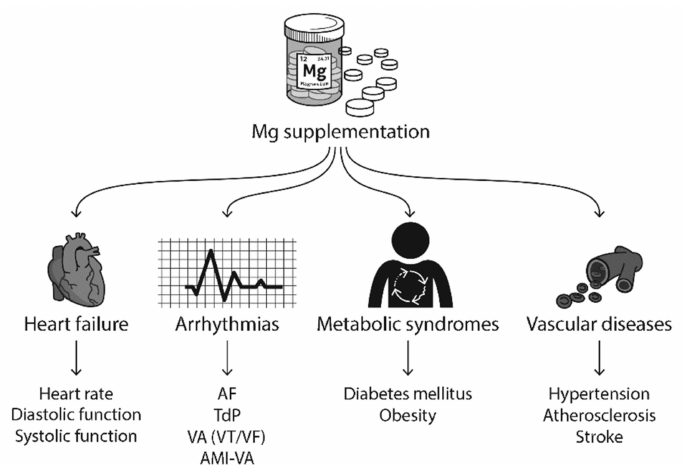
Figure 5. Mg supplementation has been reported to improve heart failure (HF), arrhythmias, metabolic syndromes, vascular diseases, and neuronal diseases in clinical studies. Abbreviations: AF, atrial fibrillation; TdP, torsades de pointes; VA, ventricular arrhythmias; VT, ventricular tachycardia; VF, ventricular fibrillation; AMI, acute myocardial